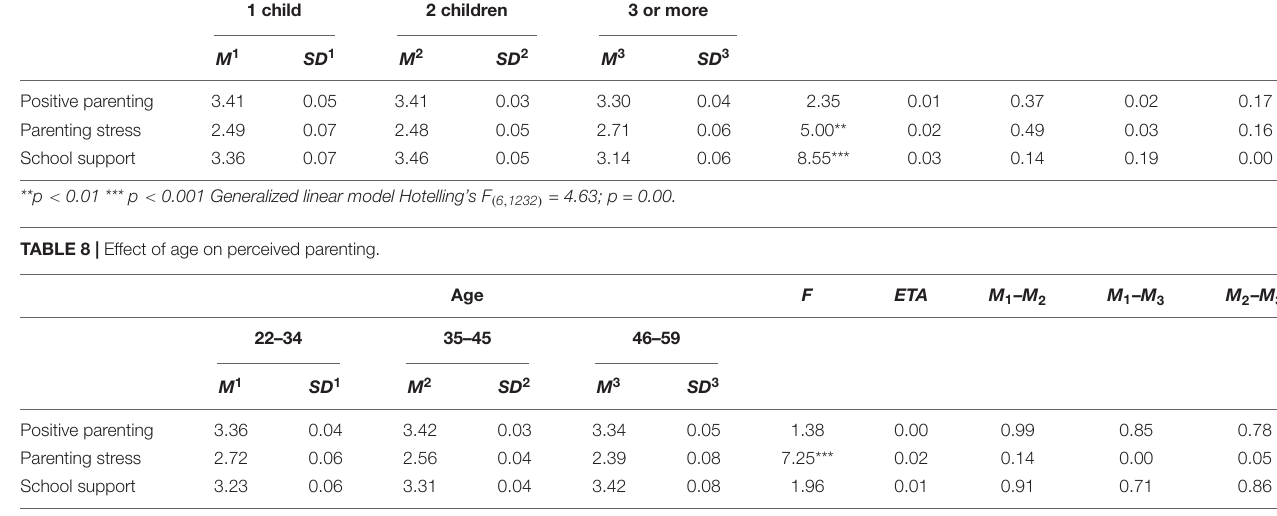
TABLE 7 | Effect of number of children on perceived parenting. Number of children F